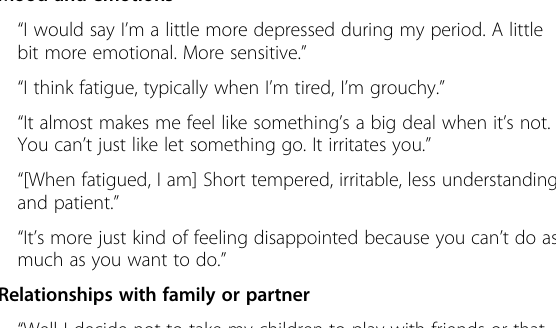
Table 4 Impacts of Endometriosis-Related Fatigue on Day-to- Day, Social, and Physical Activities